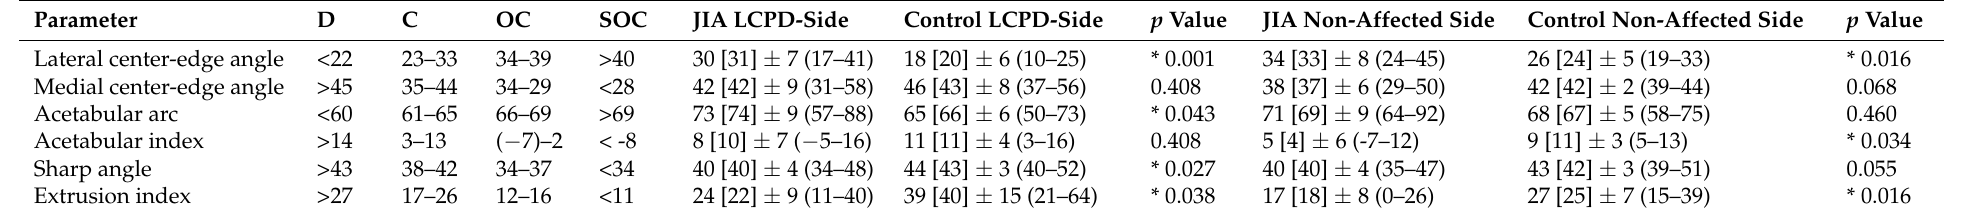
Table 5. Radiographic acetabular values at the last